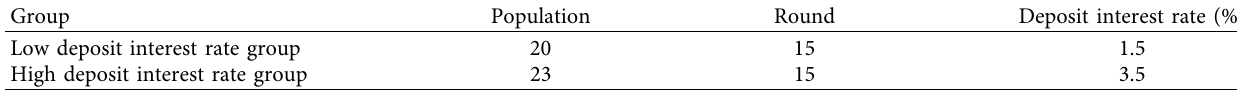
Table 1: Experimental parameter settings of the deposit interest rate group.